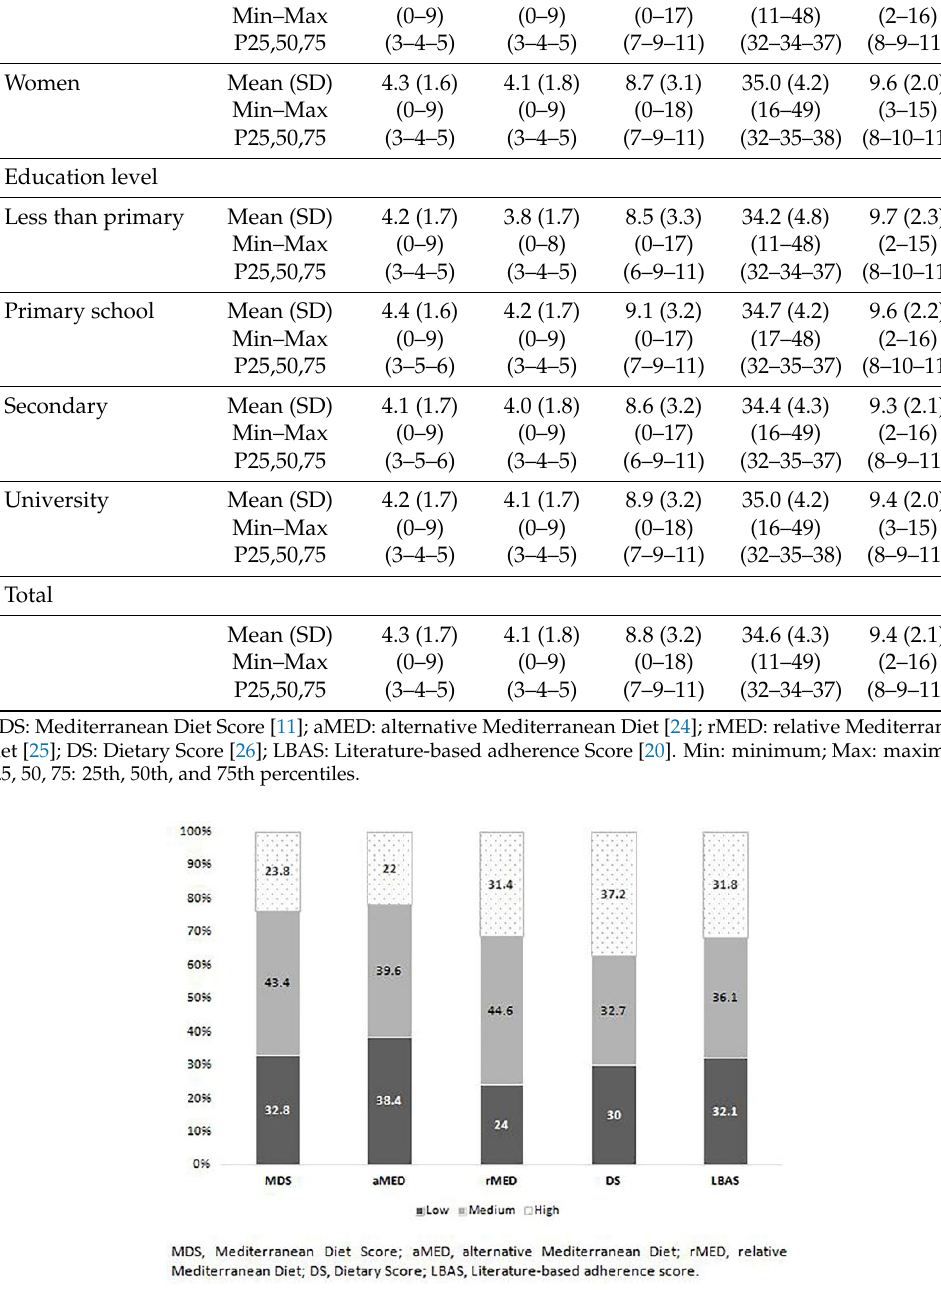
Figure 1. Descriptive analysis of levels of adherence to the Mediterranean diet; rMED, relative Mediterranean diet; DS, dietary score; LBAS, literature-based adherence score.